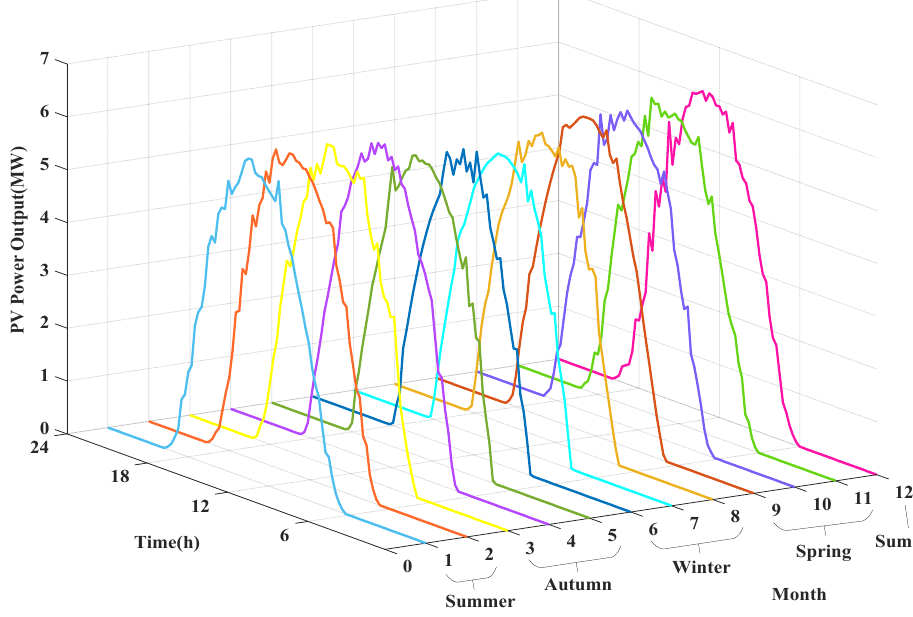
Figure 5. Monthly clear ‐ sky curve of the training set.